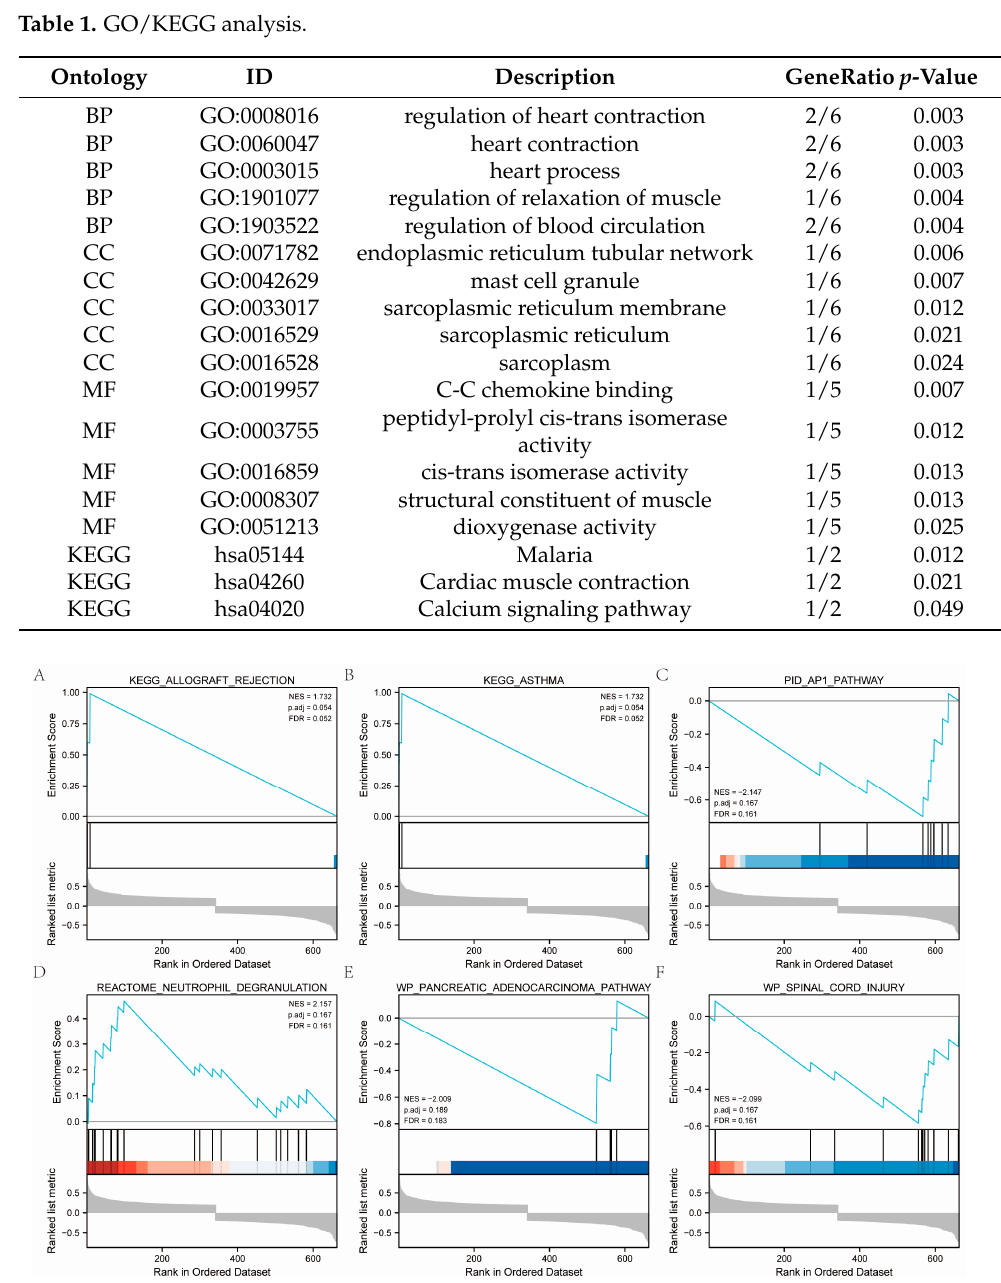
Figure 5. The results of the GSEA analysis. ( A ). KEGG_ALLOGRAFT_REJECTION, p value using the Kolmogorov-Smirnov test. ( B ). KEGG_ASTHMA. ( C ). WP_SPINAL_CORD_INJURY. ( D ). REAC- TOME_NEUTROPHIL_DEGRANULATION. ( E ). PID_AP1_PATHWAY. ( F ).